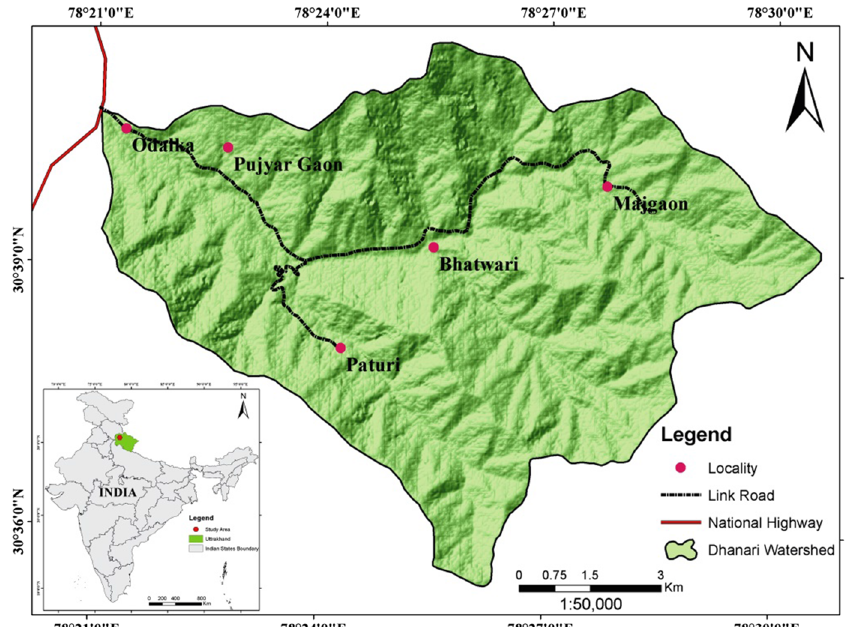
Fig. 1 Location map of the study